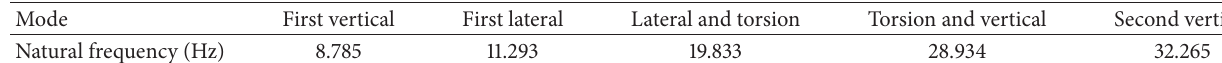
Table 4: Result of modal analysis.